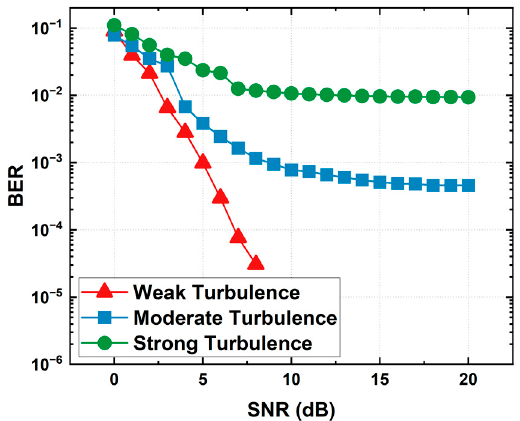
Figure 5. Constellation diagrams of ( a ) OFDM-QPSK and ( b ) and SC-QPSK at the SNR of 6 dB.